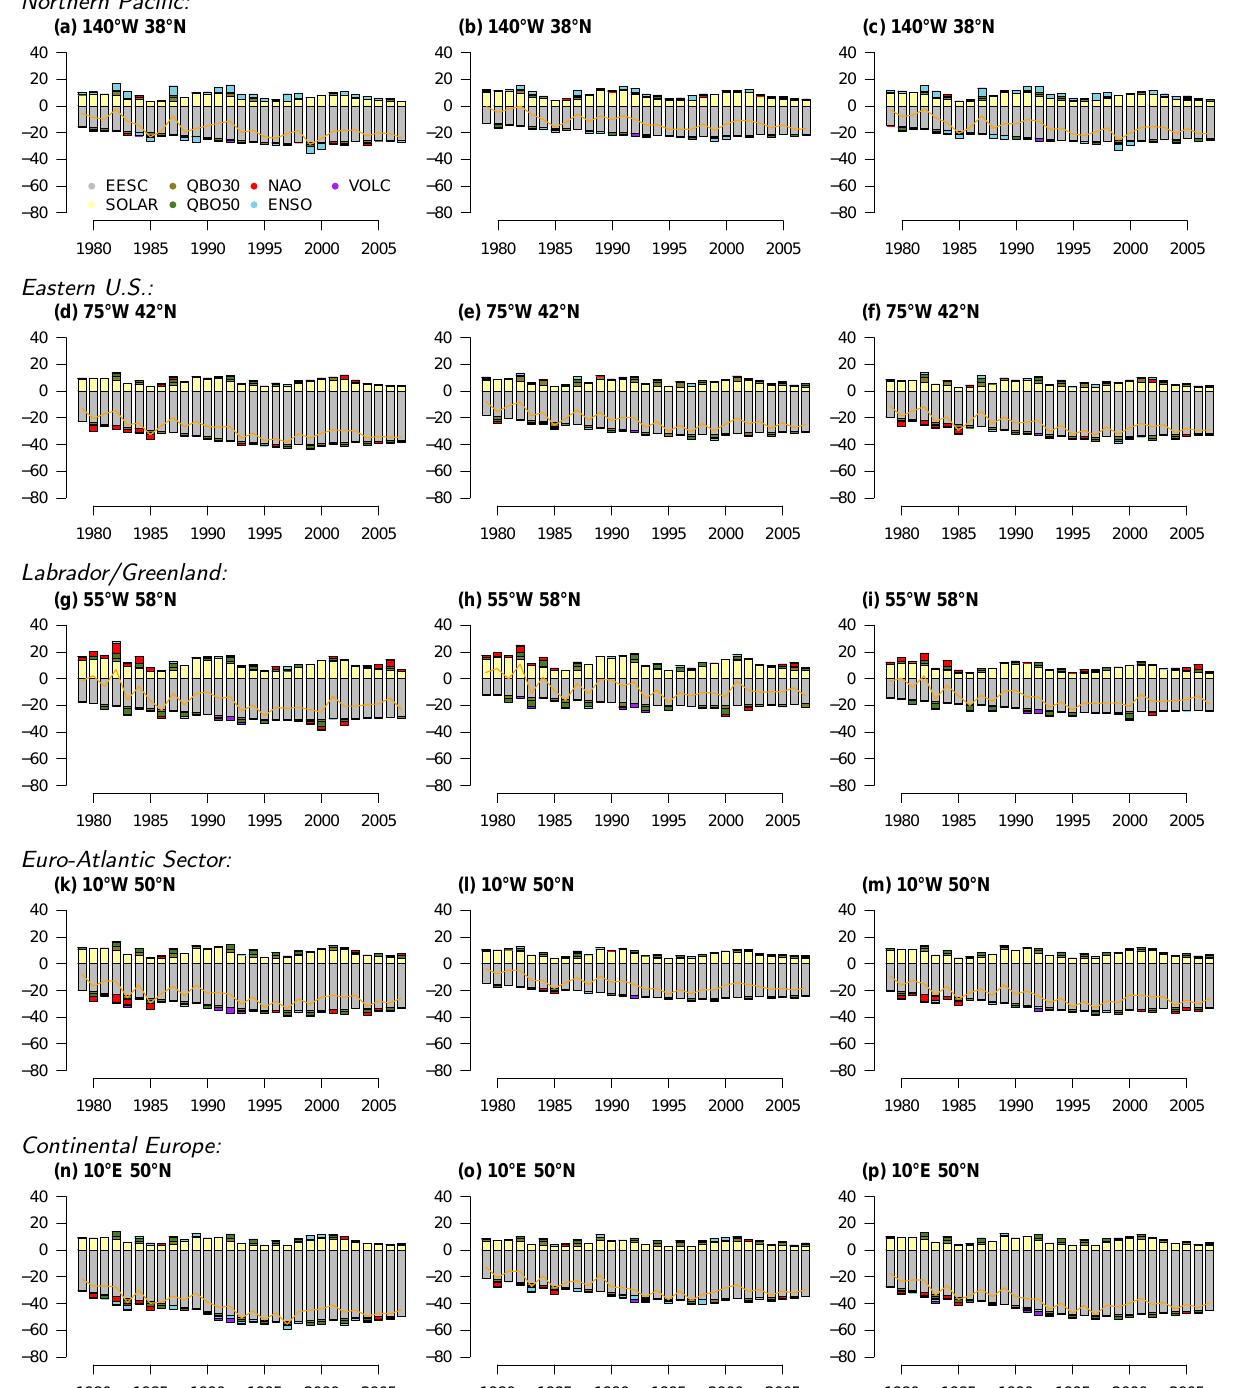
Fig. 9. Contributions of EESC (grey), solar cycle (yellow), QBO at 30 (olive) and 50hPa (green), NAO (red), ENSO (blue), and volcanic eruptions (purple) to long-term ozone changes (on an annual basis in DU) as derived from the r -largest order statistics models for EHOs (left panels (a) , (d) , (g) , (k) , (n) ), ELOs (middle panels (b) , (e) , (h) , (l) , (o) ), and as derived from the ARMA model for mean values (right panels (c) , (f) , (i) , (m) , (p) ) at selected grid cells in the northern mid-latitudes. For convenient reference the solid orange line in panels (a) – (p) gives the net contribution (sum of individual estimates) on an annual